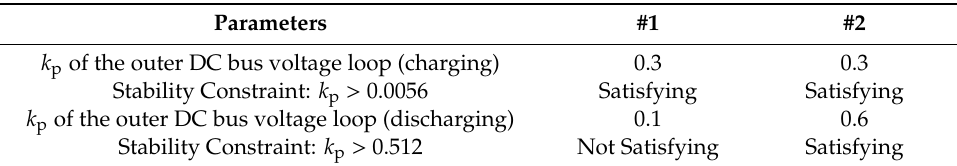
Table 1. System control parameters for simulation.